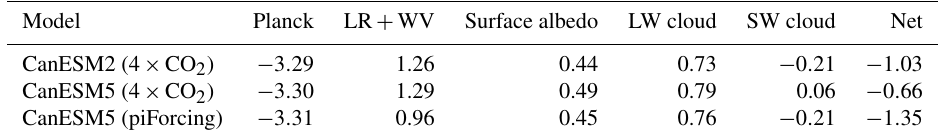
Table 2. Summary of radiative feedbacks, calculated using a combined radiative kernel and regression method (adjusted-CRE method in the case of the cloud feedbacks listed here) for both model version’s abrupt 4 × CO 2 experiments, as well as CanESM5’s AMIP-piForcing experiment. All feedbacks are in units of Wm − 2 K − 1 . Feedbacks from the AMIP-piForcing run were calculated using the 1980–2010 period as a